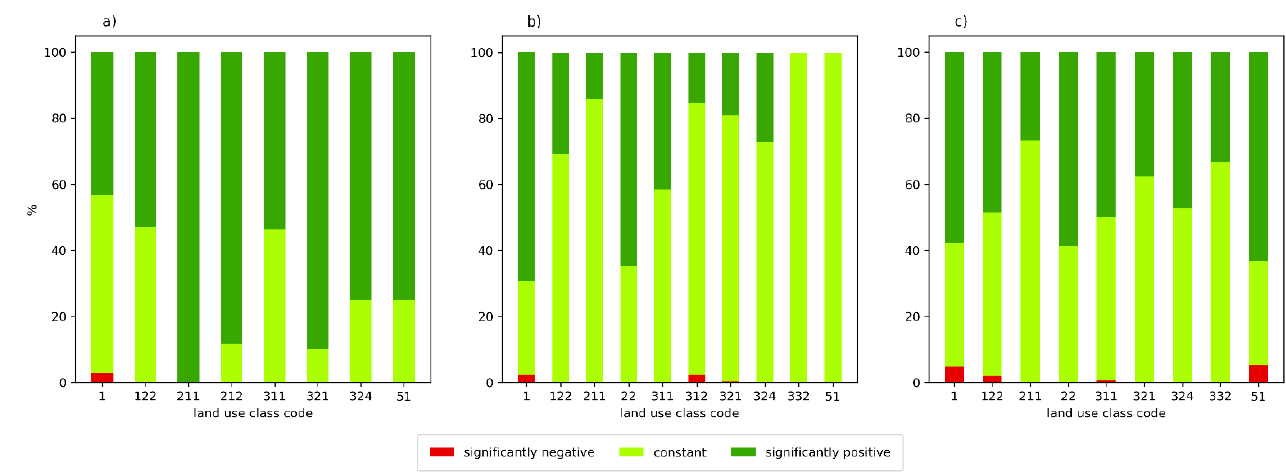
Figure 9. Percentage distribution of environmental criticality classes vs. land use class code: ( a ) Aia dei Monaci, ( b ) Montegrosso-Pallareta, ( c ) Vallone Calabrese. Land use class codes are described in Table 1.